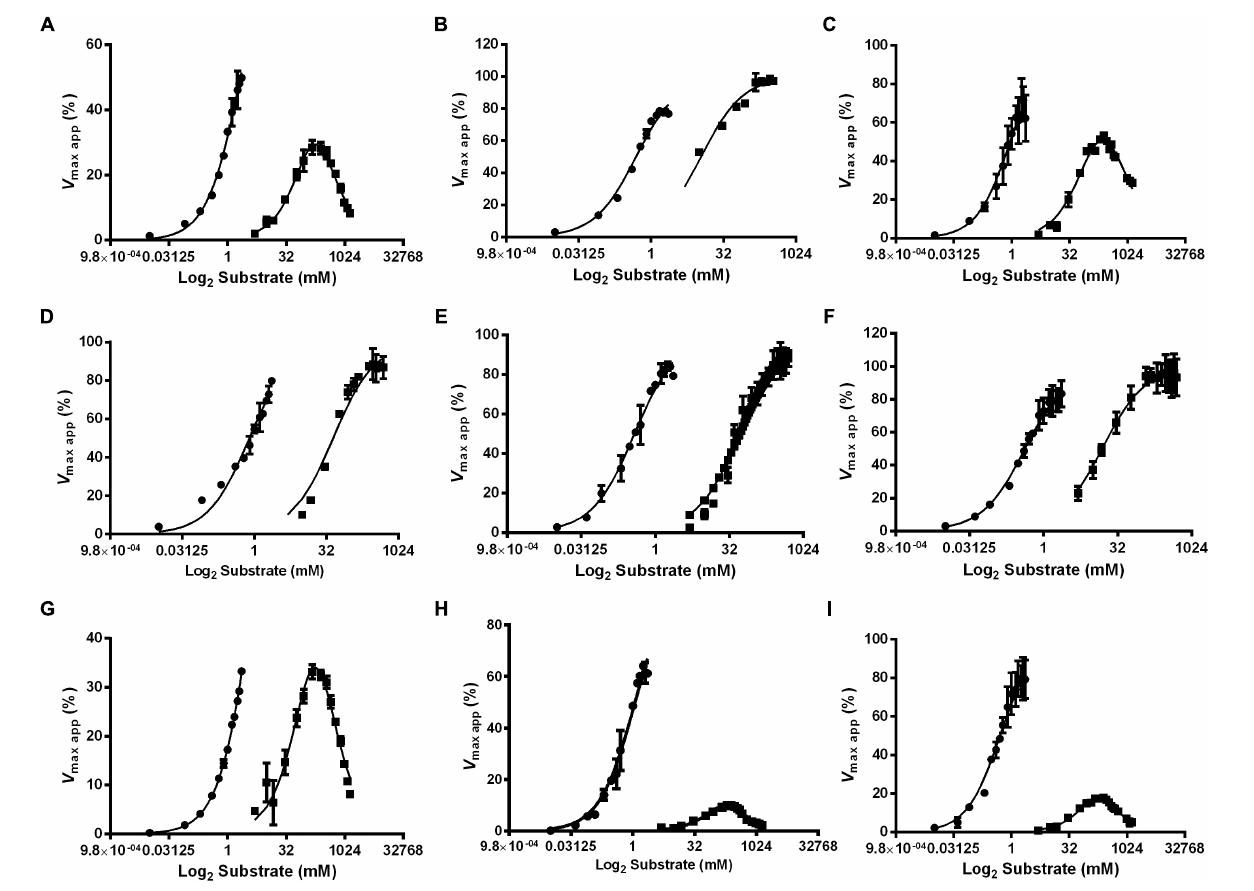
FIGURE 6 | Effect of the substrate concentration on α -glucosidase activity in different feeding conditions and tissues of L. longipalpis females. Samples were obtained from recently emerged females (0–3 h) (A,D,G) , females fed with 1.2 M sucrose for 2 days (B,E,H) and females after 2 days of blood feeding (C,F,I) . For each feeding condition, crop (A–C) , midgut contents (D–F) and midgut tissue homogenates (G–I) were analyzed. MU α Glu (dark circles) and sucrose (dark squares) were used as substrates. The points are experimental results and lines were calculated based on constants computed with the software Graphit using the least-squares method. Note the inhibition by excess of sucrose as substrate. V max app (%) was calculated using experimental results compared to values found using the Graphit software (described in Tables 2 , 3